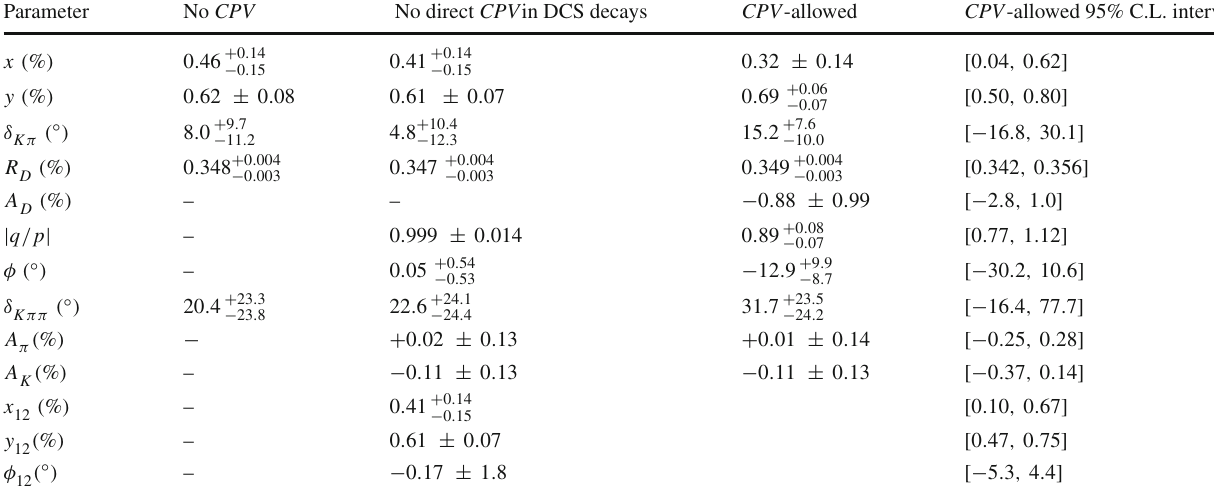
Table 262 Results of the global fit for different assumptions concerning CPV Parameter No CPV No direct CPV in DCS decays CPV